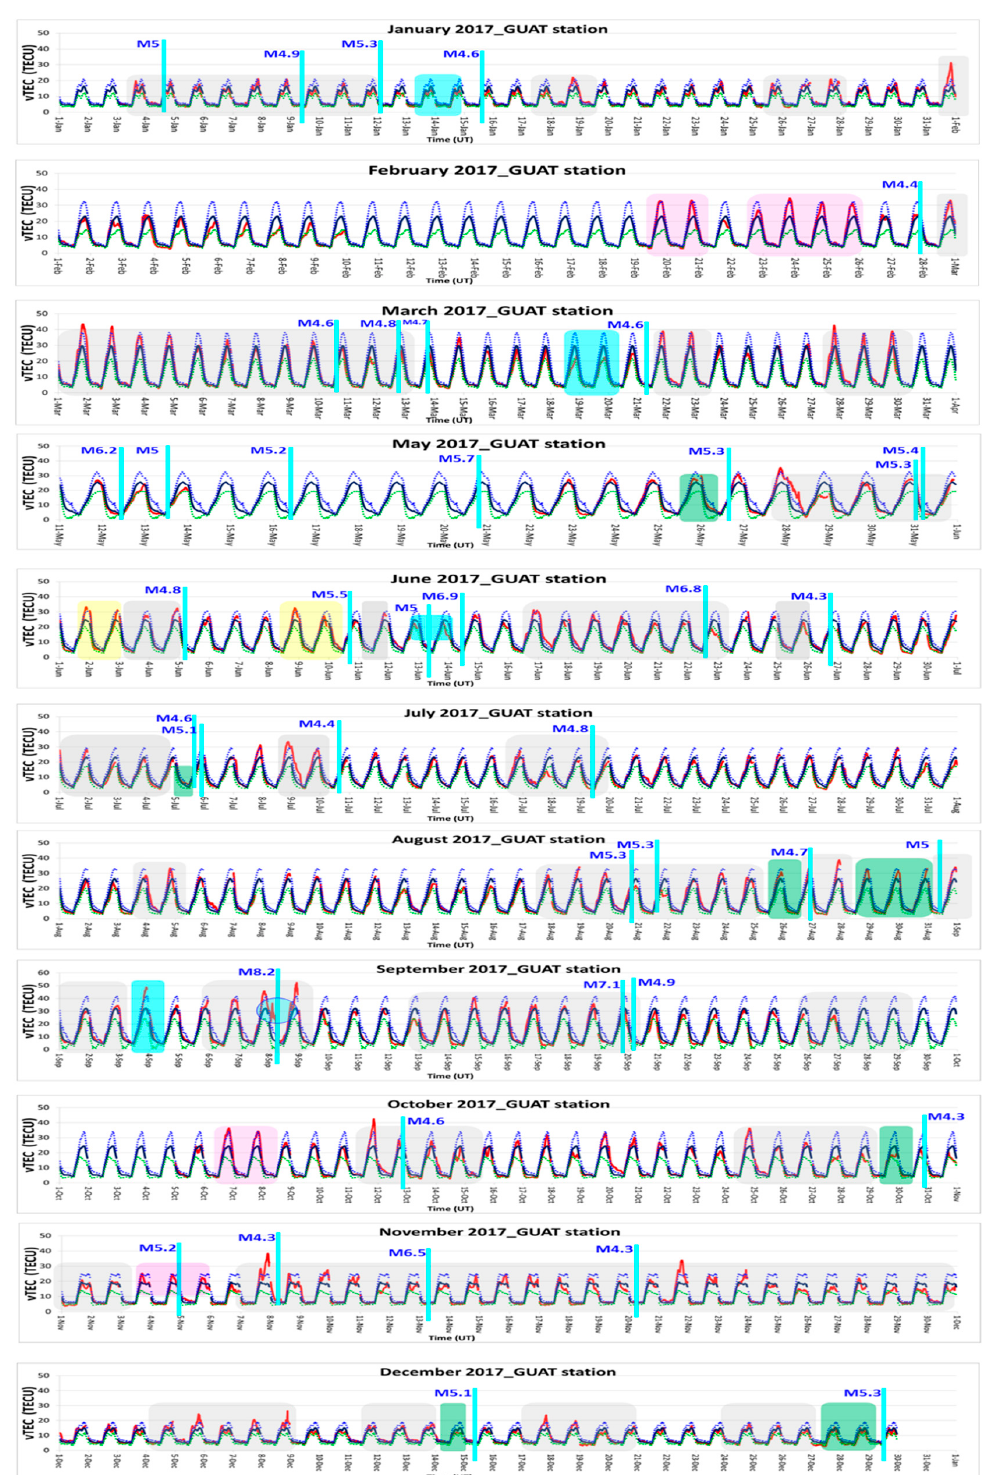
Figure 5. Daily TEC variations (red solid line) along with its upper (blue dotted line) and lower bounds (green dotted line) fixed at μ ± 1.34 σ and mean TEC variations μ (black solid line) are depicted for GNSS station GUAT for each month of 2017. Light blue vertical lines show the occurrence of examined earthquakes. The grey-shaded areas mark the days with geomagnetic unsettled or disturbed conditions, light blue areas mark TEC anomalies of seismic origin, green-shaded areas denote anomalies close to geomagnetic disturbed conditions, light-pink areas denote typical TEC enhancements over Mexico and light-yellow areas include TEC anomalies that could be either due to earthquake or to typical TEC enhancements over Mexico.